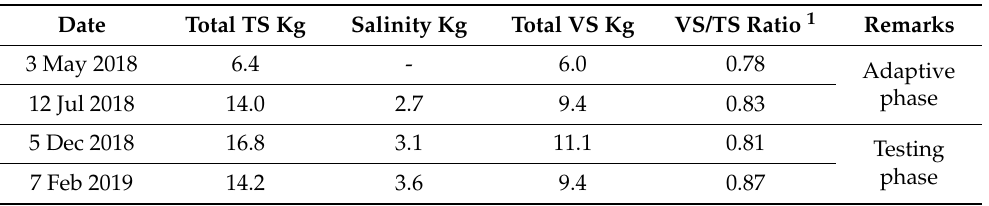
Table 6. Total and Volatile solids data of samples collected from 4 different heights of EGSB.